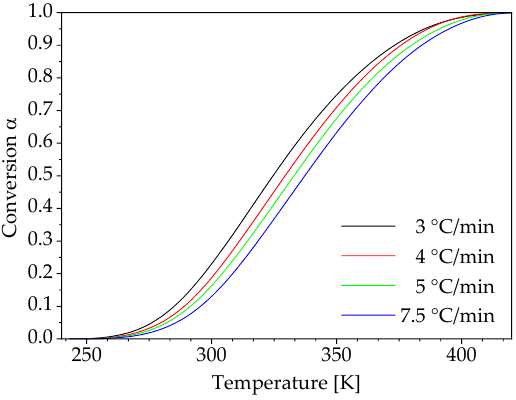
Figure 5. Temperature-dependent conversion under non-isothermal curing conditions.